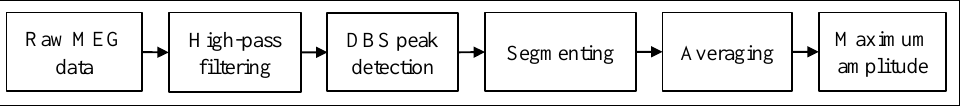
Figure 7. Signal processing pipeline: Each measured MEG signal was high-pass filtered with a 60 Hz cutoff frequency, segmented into short DBS periods (according to the locations of DBS peaks detected by a peak detection algorithm), and averaged to a single time period. The maximum amplitude value was then